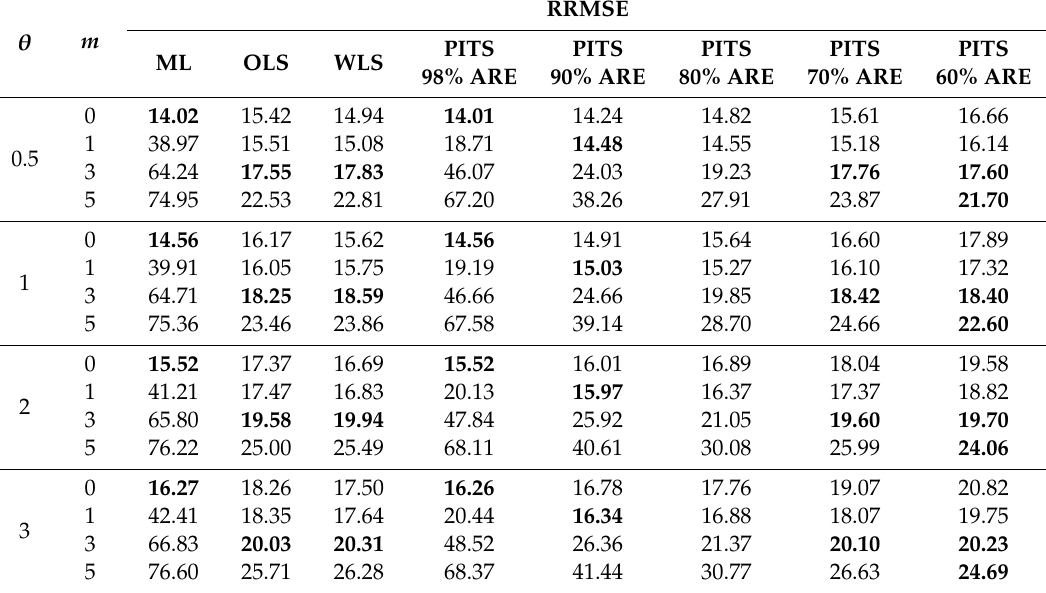
Table 3. Relative root mean square error (RRMSE) results for estimations of parameter θ with n = 30 and m = 0, 1, 3, 5.